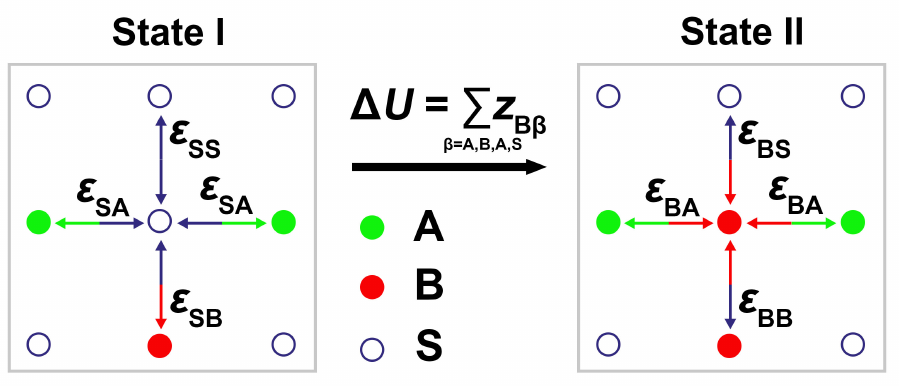
Figure 1. 2D illustration of the energy contribution due to the exchange of a solvent bead S and polymer bead B in a given lattice position. In State I, the central lattice point is occupied by bead S, and its contribution to the total energy of system is U I = ε SA + ε SB + ε SA + ε SS . In State II, this point contains bead B, and its contribution to the total energy of system is U II = ε BA + ε BB + ε BA + ε BS . Therefore, the energy change due to the replacement of the solvent bead by polymer bead is ∆ U = U − U = 2 ( ε − ε ) + ( ε − ε ) + ( ε − ε ) = 2 z + z + z II I BA BB BA BB SA SB BS SS BS